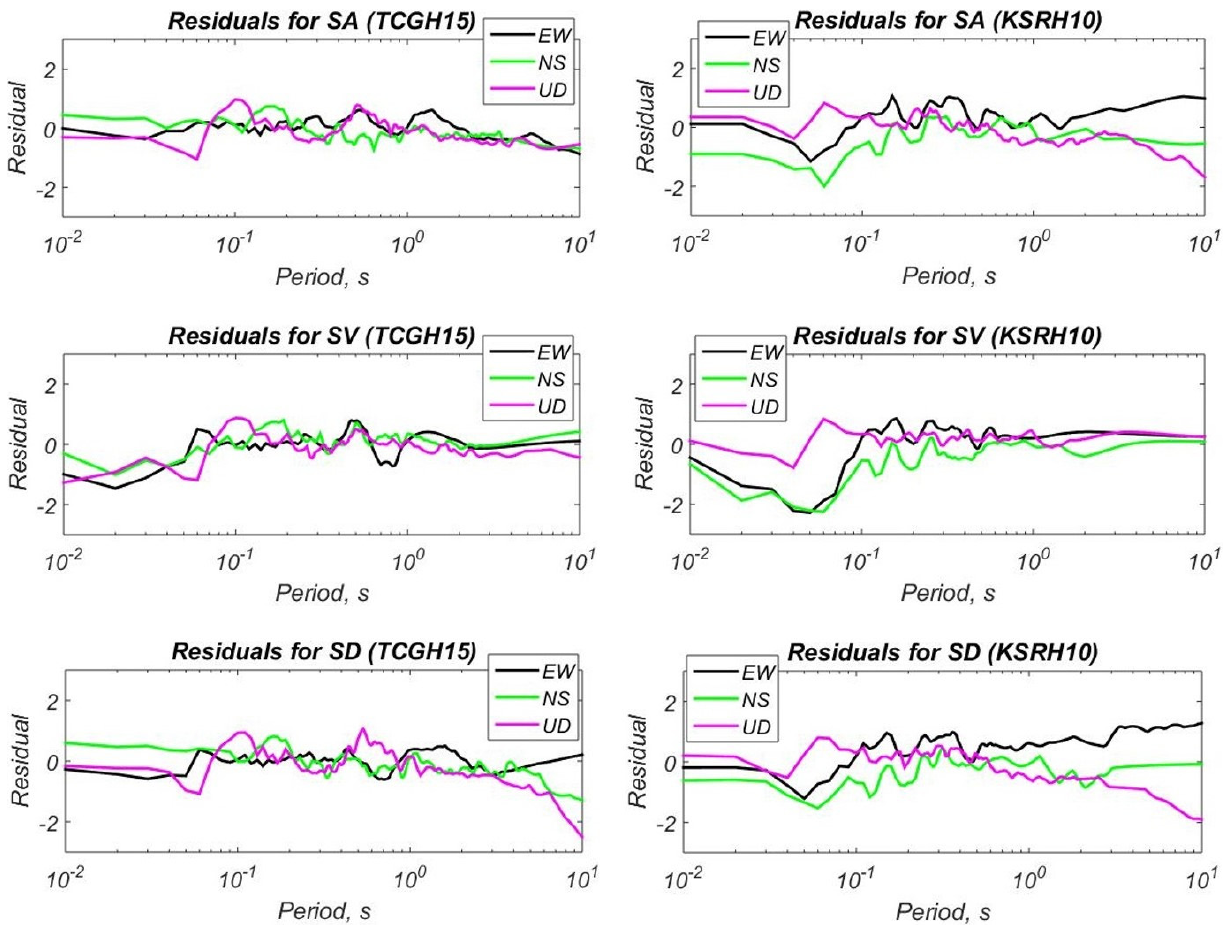
Figure 11. Residuals of response spectra (damping 5%) of modeled and recorded accelerograms (components EW, NS, UD; spectral acceleration—SA, spectral velocity—SV, spectral displacement—SD) calculated for the surface of soil layers at Kik-net sites TCGH15 and KSRH10.